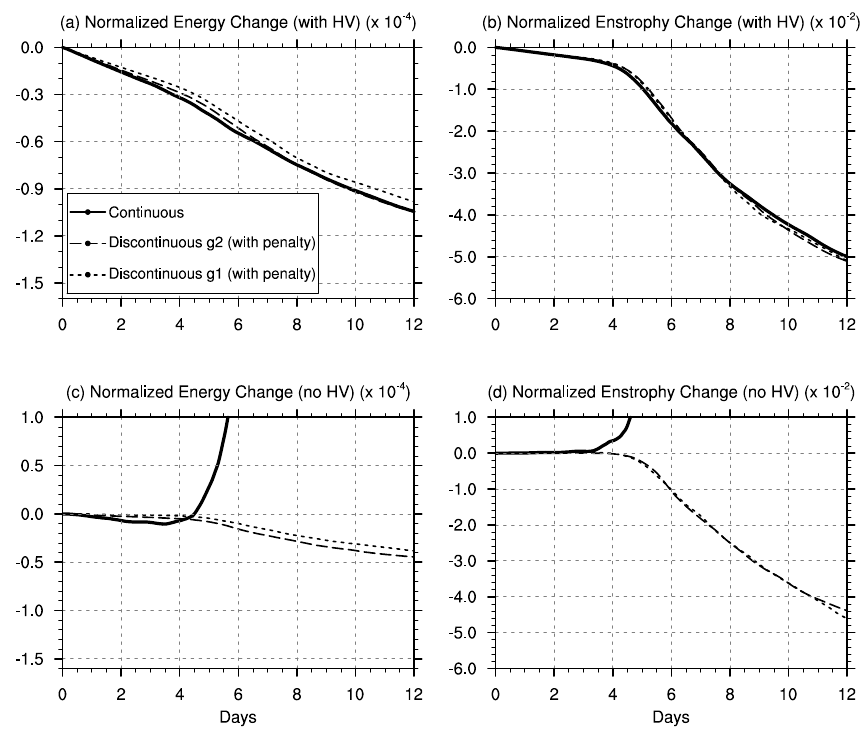
Figure 11. Normalized total energy and enstrophy change for the barotropic instability test with n e = 16 and n p = 4 over a 12-day simulation. In (c) and (d) the continuous element simulation fails after approximately 6 days, leading to unbounded growth in energy and enstrophy. The time step used for these runs was (a,d) ∆ t = 300 s, (b,e) ∆ t = 150 s and (c,f) ∆ t = 75 s. Discontinuous penalization was used for both discontinuous schemes.